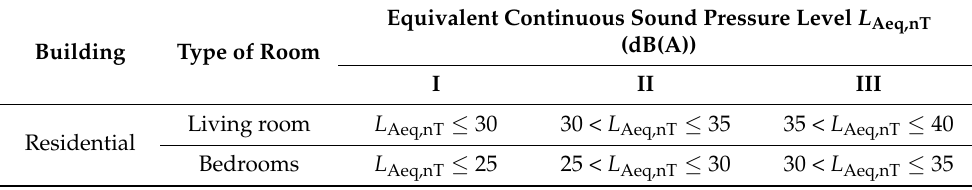
Table 1. Equivalent continuous sound pressure level standardized to a reference reverberation time, L Aeq,nT, for continuous sources (EN 16798-1).